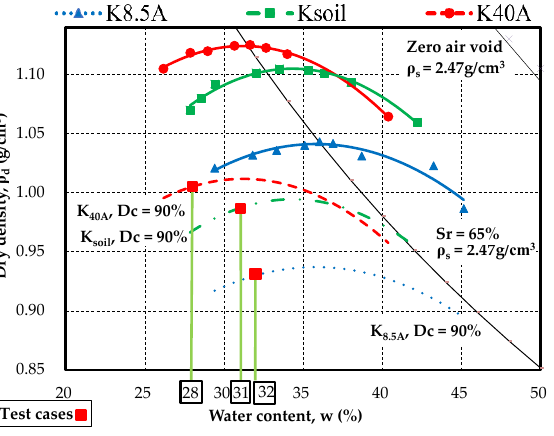
Figure 3. Compaction curve of test samples in this study, according to the A-b method [28].